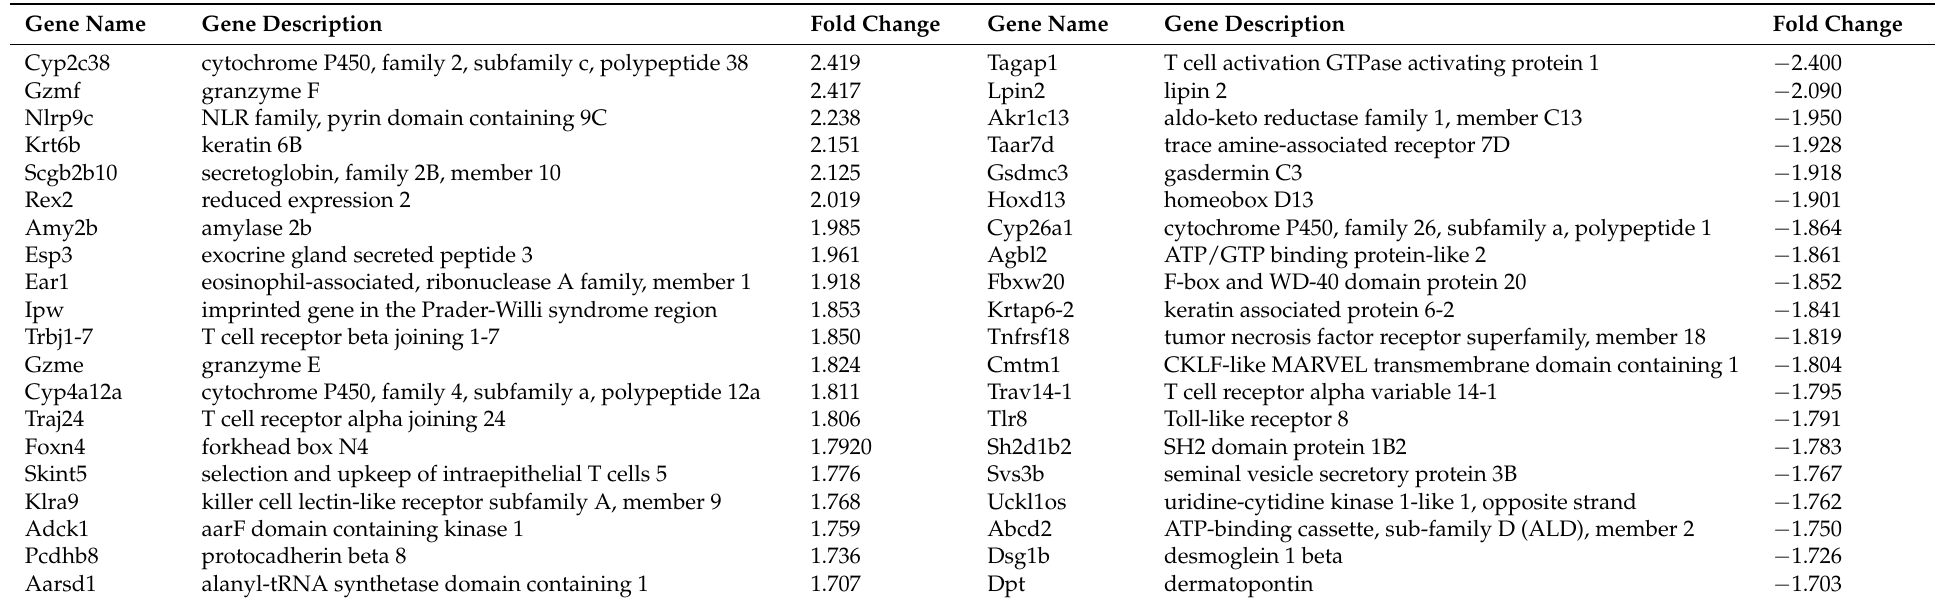
Table 3. List of top 20 up and downregulated genes in 24 h cisplatin